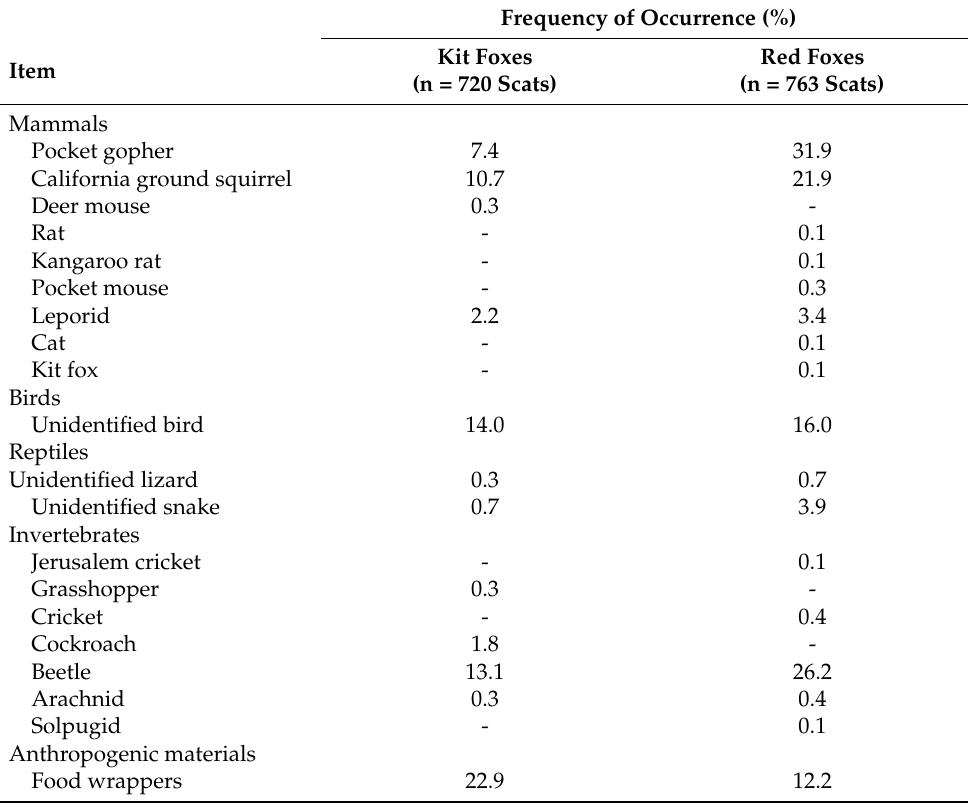
Table 2. Frequency of occurrence of items in scats from urban kit foxes and red foxes in Bakersfield, California, during